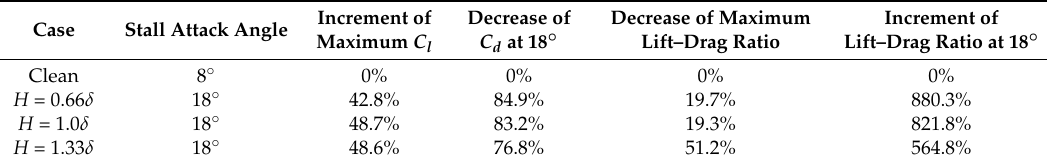
Figure 18. Lift coefficient, drag coefficient, and lift–drag ratio of airfoils with and without VGs. ( a ) coefficient, ( b ) Drag coefficient, ( c ) Lift–drag ratio. Lift coefficient, ( b ) Drag coefficient, ( c ) Lift–drag ratio. Table 6. Relative variation of C l , C d , and lift–drag Table 6. Relative variation of C l , C d , and lift–drag ratio.